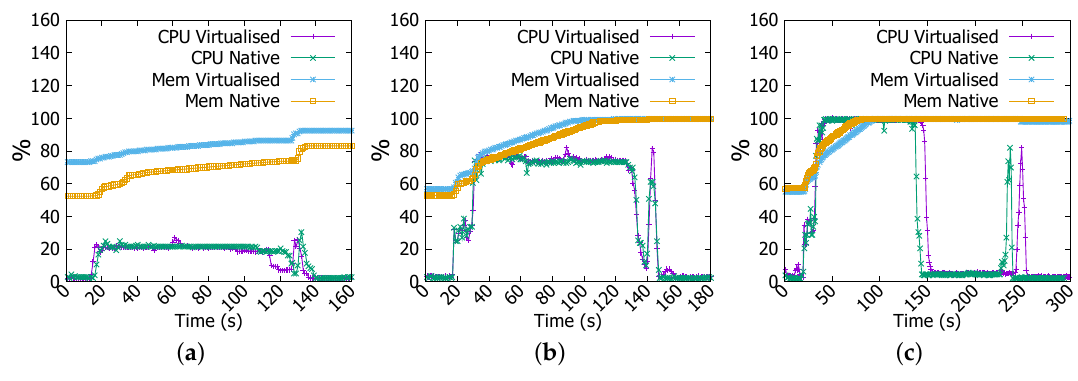
Figure 10. CPU and memory usage in Sort job. ( a ) 1 GB file; ( b ) 4 GB file; ( c ) 6 GB